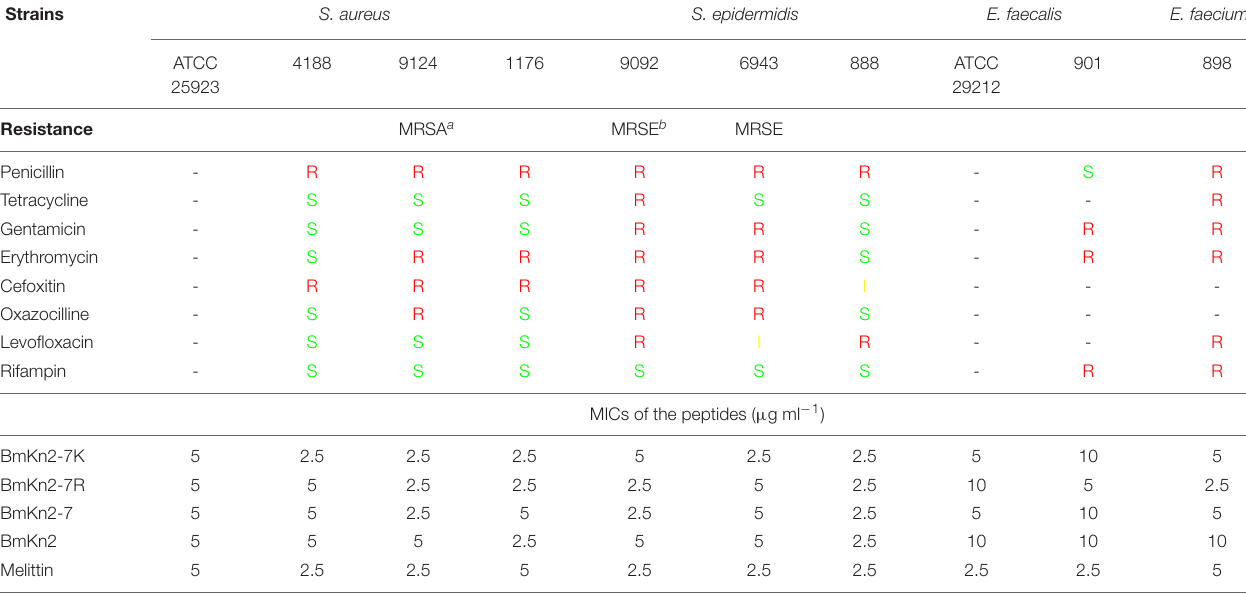
TABLE 3 | Minimum inhibitory concentrations of BmKn2-7K against clinically isolated gram-positive pathogens.